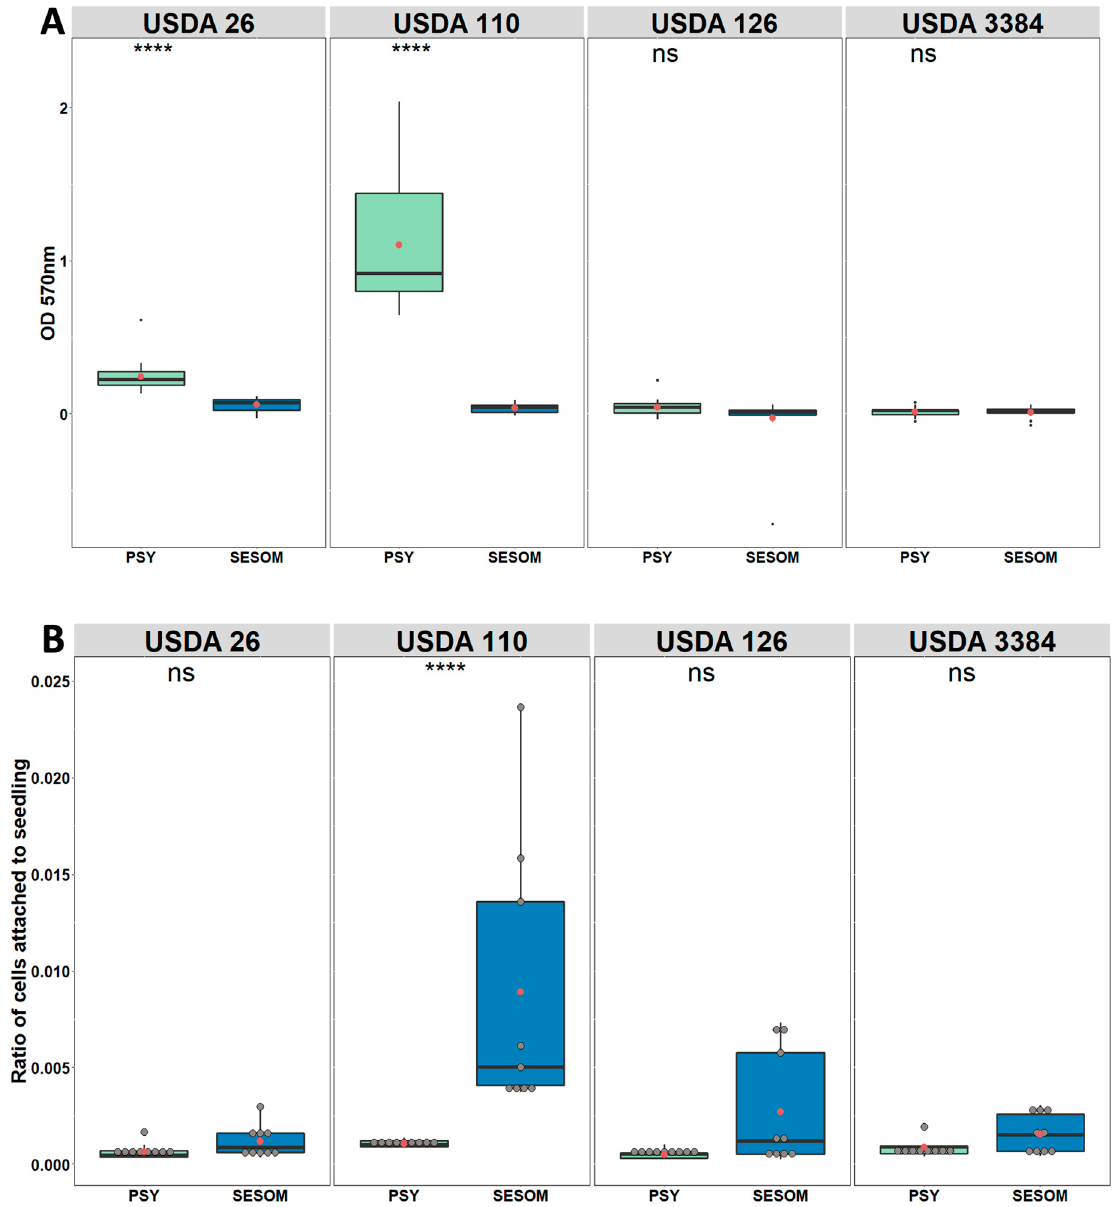
Figure 5. Biofilm ( A ) and soy root adherence ( B ) of Bradyrhizobium strains. Exponential phase Bradyrhizobium cultured in either PSY-Arabinose or SESOM were inoculated into 96-well polystyrene plates and biofilm formed after 24 h quantified by crystal violet staining ( A ), or exposed to 9 d old roots for 60 min ( B ). Data were analyzed by Student t -test, and p values indicate statistical significance (ns not significant, **** p <